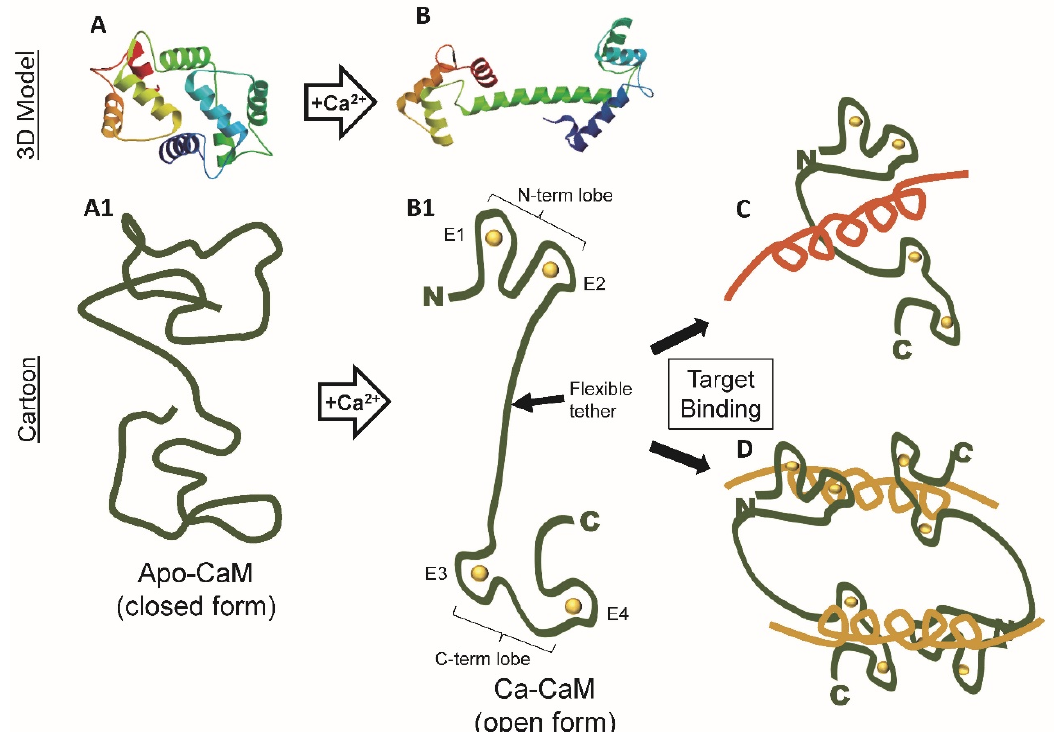
Figure 2. Simple line drawings depicting the fundamental CaM conformation in apo- ( A , A1 ) versus calcium-bound ( B , B1 ) calmodulin plus two calcium-dependent CaMBP interactions ( C , D ). Three-dimensional (3D) Model, Dictyostelium CalA (Swissprot modeling); Cartoon: Target binding examples: C, myosin light chain kinase, D: small conductance Ca 2+ -activated potassium channel (SK2).